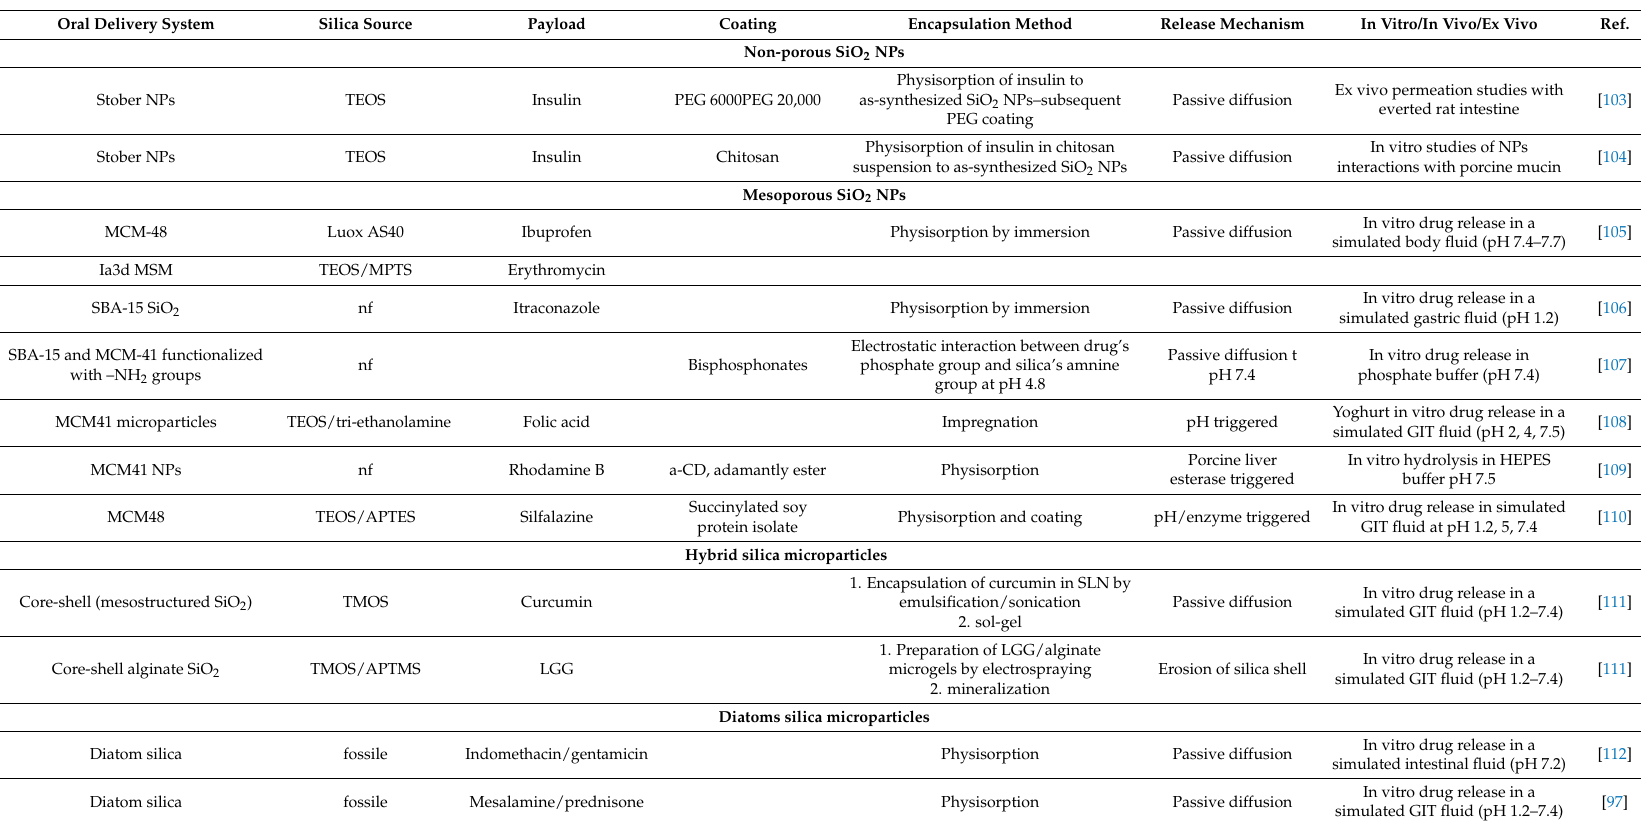
Table 4. Sol-gel silica-based oral delivery NPs (adapted and reproduced with permission from